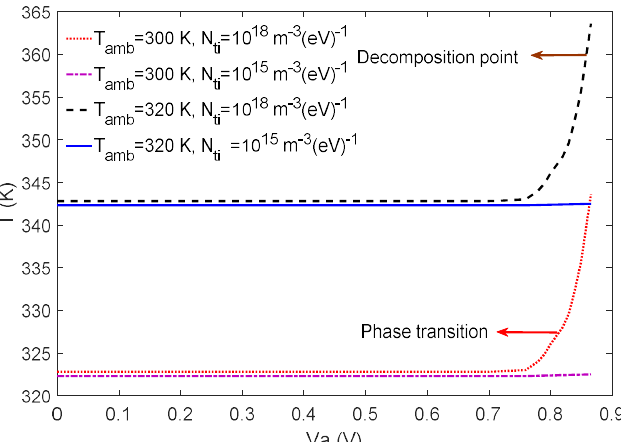
Figure 6. The operating temperature in the active layer plotted as a function of the applied voltage at two ambient temperatures of 300 K and 320 K.